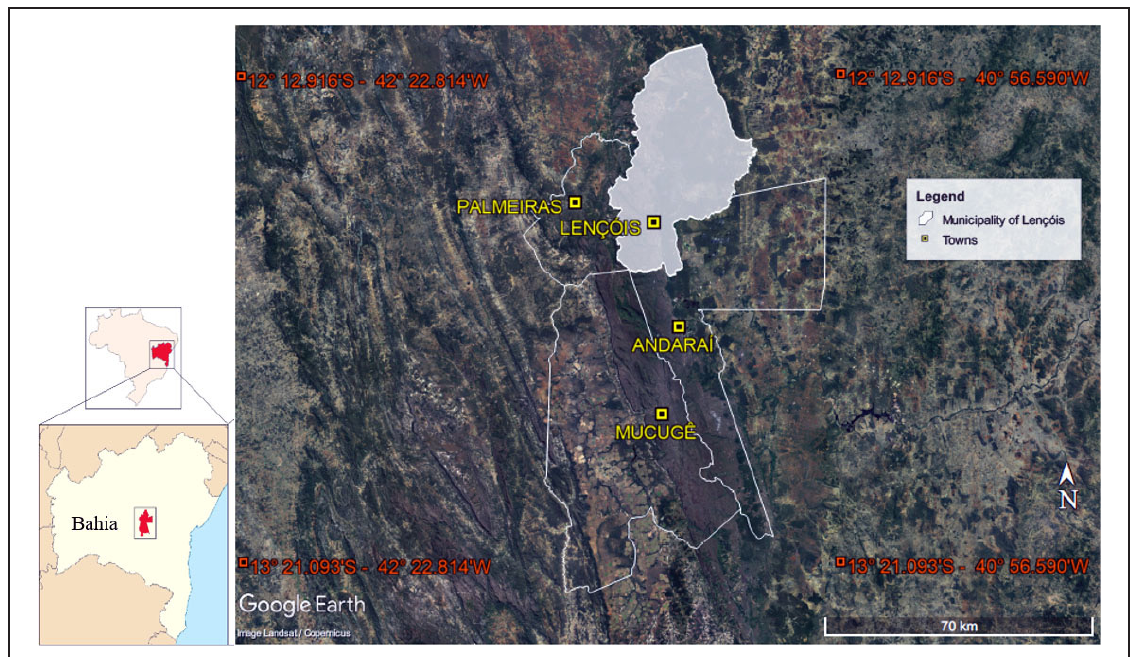
FIGURE 1 . Location map of municipalities in the territory of the Serra do Sincorá Geopark Project, Bahia. Modified from Google Earth